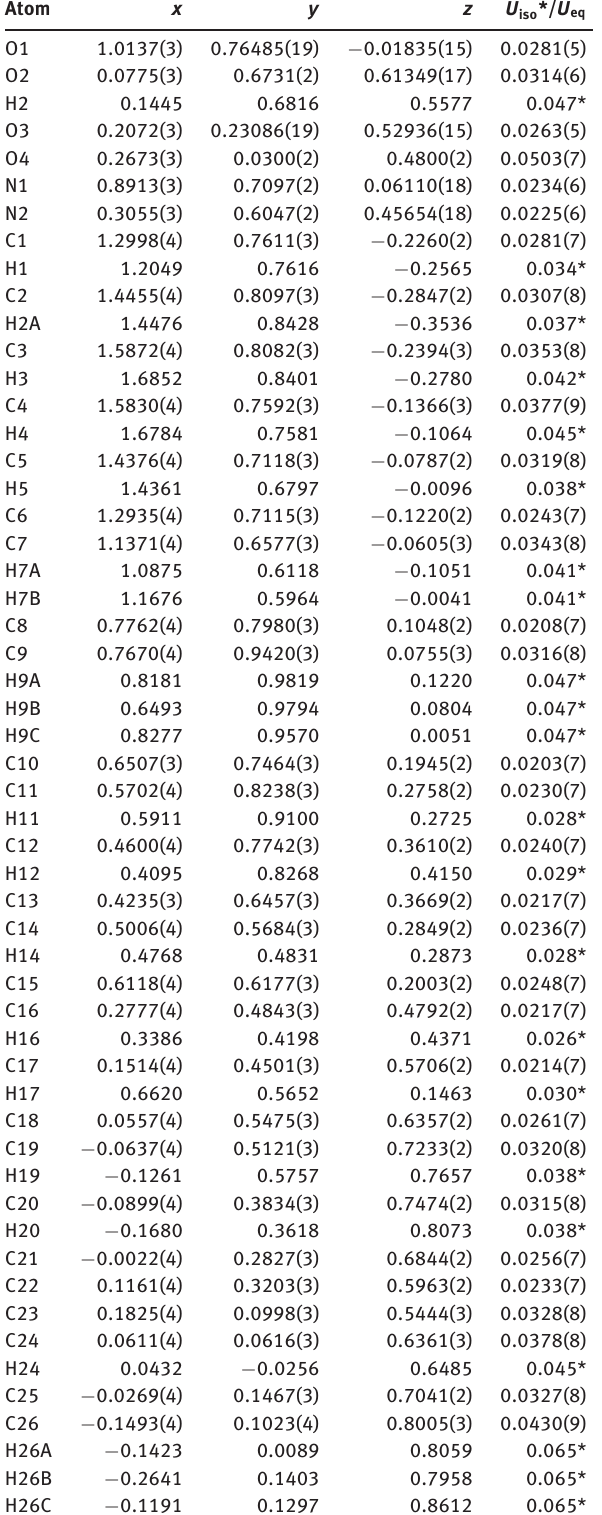
Table 2: Fractional atomic coordinates and isotropic or equivalent isotropic displacement parameters (Å 2